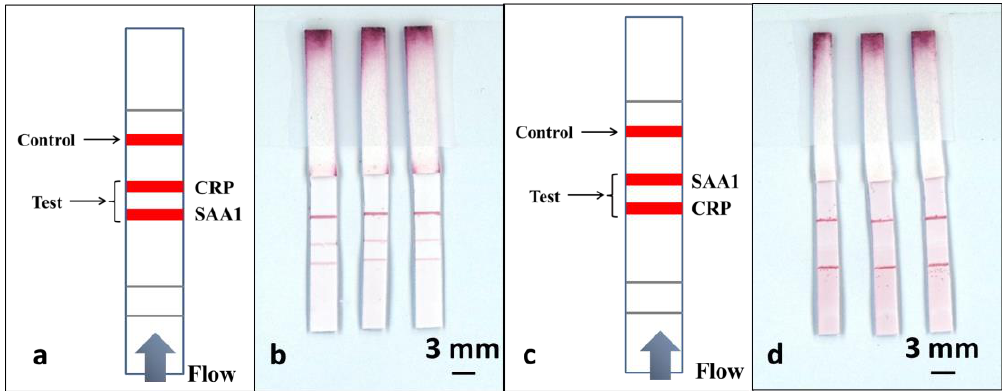
Figure 5. Schematic of a single-channel multiplexed LFD with multiple test lines along the same flow-path for multiplexed detection of CRP and SAA1, ( a ) with the SAA1 test line being before that for CRP and ( c ) with the CRP test line before that for SAA1. ( b , d ) are scanned image shows the results for three such LFDs described in ( a , c ).